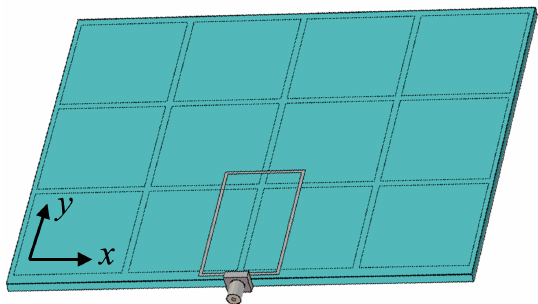
Figure 17. Perspective view of the modeled wearable loop antenna with HIS structure in CST MWS.